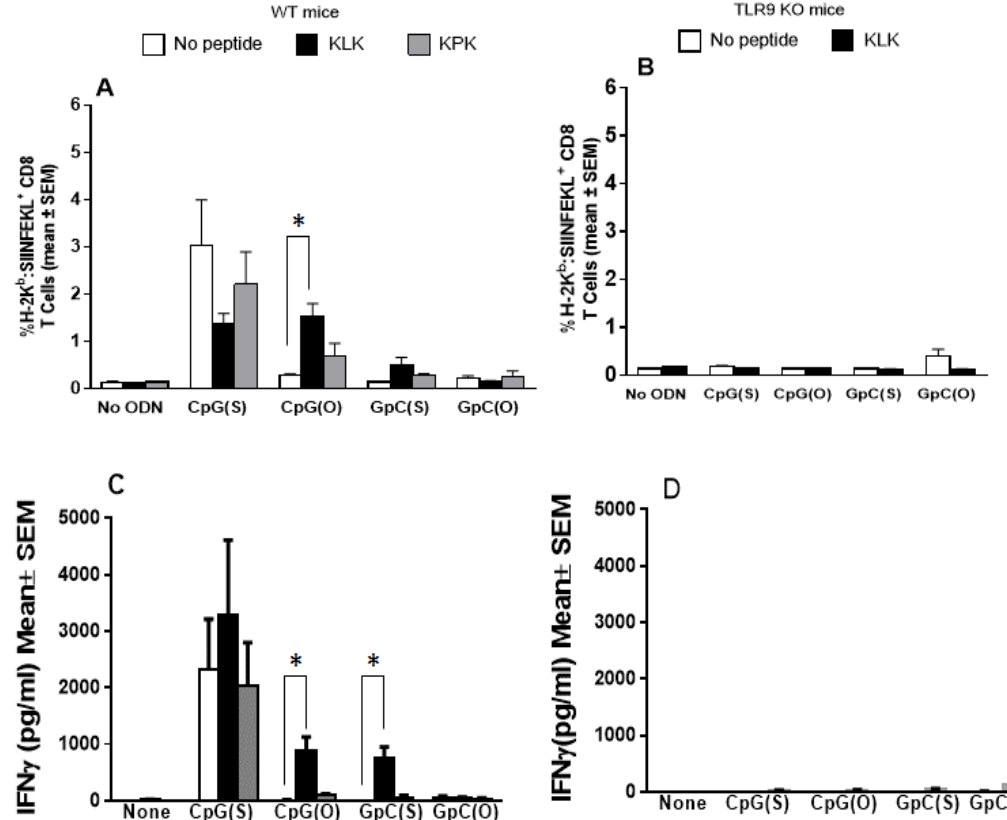
Figure 2. Wild type C57Bl/6 (Panel A & C) or TLR9 deficient (Panel B & D) mice ( n = 5/group) were immunized at week 0, 2 and 3 by IM injection with unadjuvanted OVA (10 µ g) or OVA adjuvanted with CpG(S), CpG(O), GpC(S), GpC(O) ODN (4 nmol) alone or in combination with KLK or KPK (only WT mice) peptides (100 nmol). ( A , B ): Splenocytes collected 1 week after final immunization were used to determine the percentage of OVA tetramer positive CD8 populations as measured by FACS. Bars represent the group mean ( ˘ SEM) for the % OVA-specific CD8 T cell population within the total splenic CD8 T cells; ( C , D ): Splenocytes collected one week after final immunization were re-stimulated with 0.5 mg/mL of OVA for 72 h. Level of IFN γ in culture supernatants were determined by ELISA. Bars represent the mean cytokine concentration (pg/mL) ± the standard error. Significant differences between groups is shown by * where *= p < 0.05.